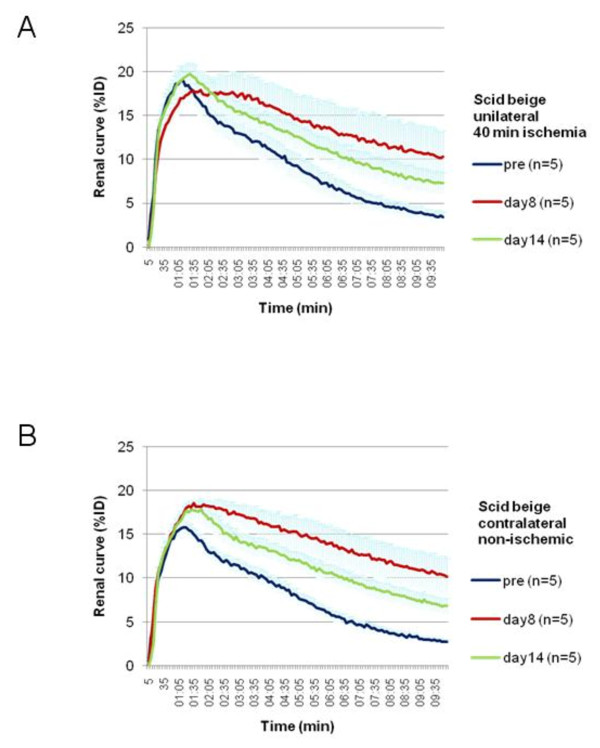
Ischemic and contralateral non-ischemic kidney renograms before injury and at follow-up examinations days after ischemia. (A) Renal ischemia of 40 min was associated with kidney dysfunction 8 days after injury reflected by a reduced slope and decreased uptake and persisted at day 14. (B) While the peak height increases after injury, no changes of the slope were found during follow-up which was 8 days after injury.